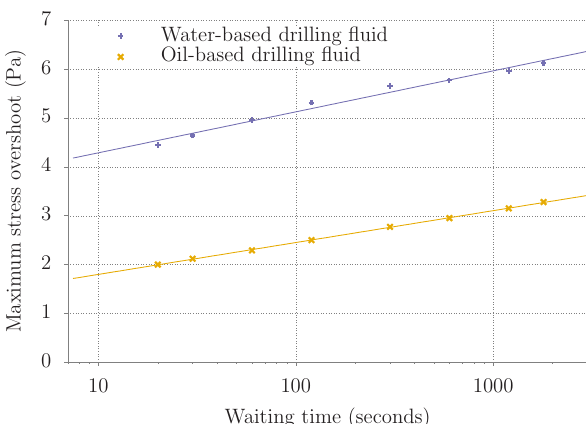
Figure 4: Maximum stress overshoot during flow start-up for differ- ent resting times.